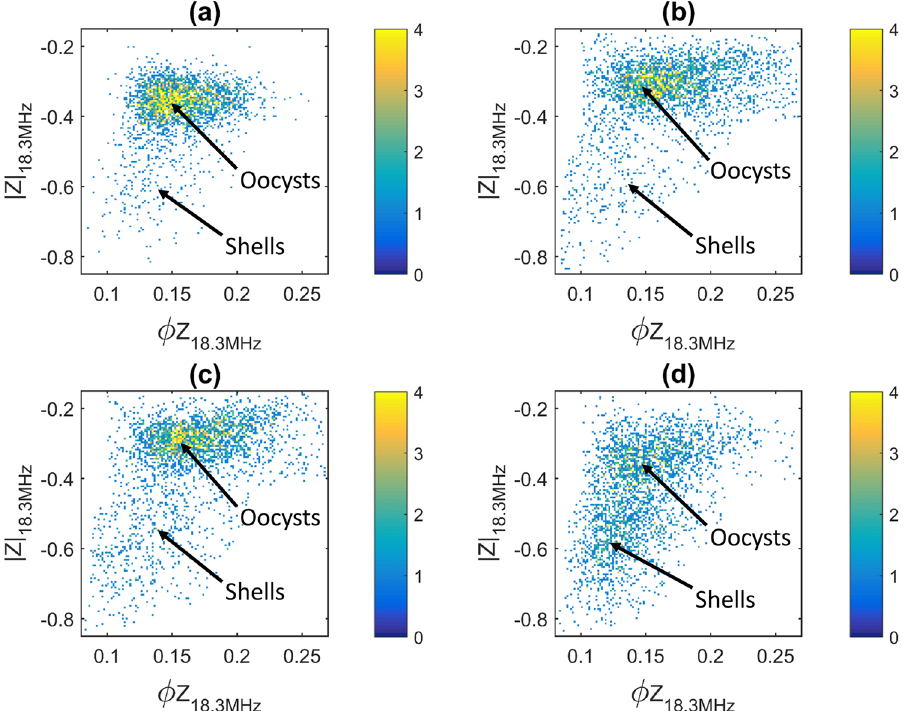
Figure 4. Example impedance scatter plots for four untreated C. parvum samples at a frequency of 18.3 MHz measured in 0.5x PBS of conductivity σ m = 0.76 S m − 1 . Each data point is a single oocyst and colour represents data density. The first 3000 detected events are plotted in each figure subset and oocyst and shell populations are annotated as per the analysis described in the modelling section. ( a ) Calf-sourced oocysts (Iowa strain) measured within 1 month of oocyst propagation. ( b ) Mouse-propagated oocysts (Iowa strain) used within 1–2 months. (c) Different sample of calf-sourced oocysts (Iowa strain) used within 1–2 months. ( d ) Calf-sourced C. parvum (Moredun strain) measured within 2–3